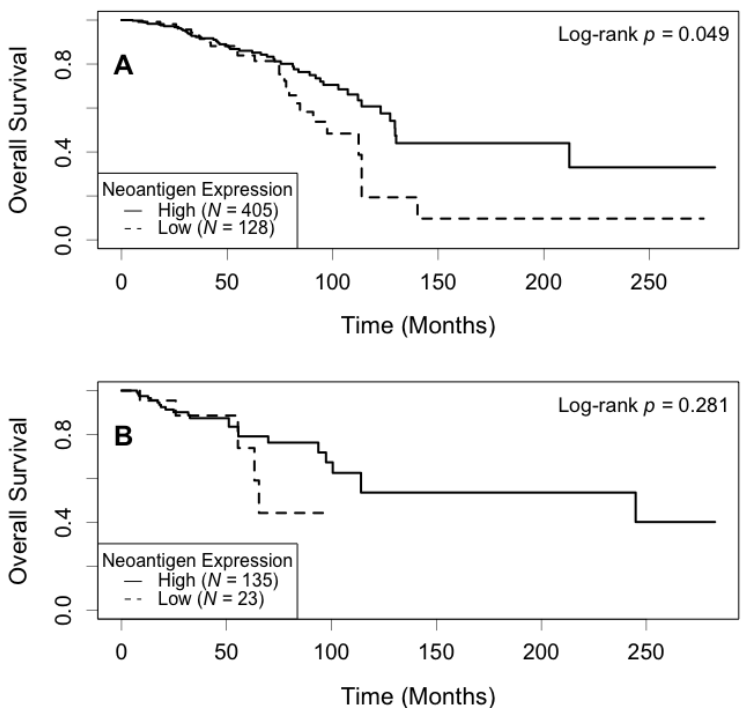
Figure 3. Kaplan–Meier survival curve of neoantigen expression stratified by ER status. ( A ) In the ER positive subgroup, patients with a high level of neoantigen expression had better overall survival compared to those with a low level ( p = 0.049); ( B ) In the ER negative subgroup, there was no significant difference in survival between patients in the high and low levels of neoantigen expression ( p = 0.281).